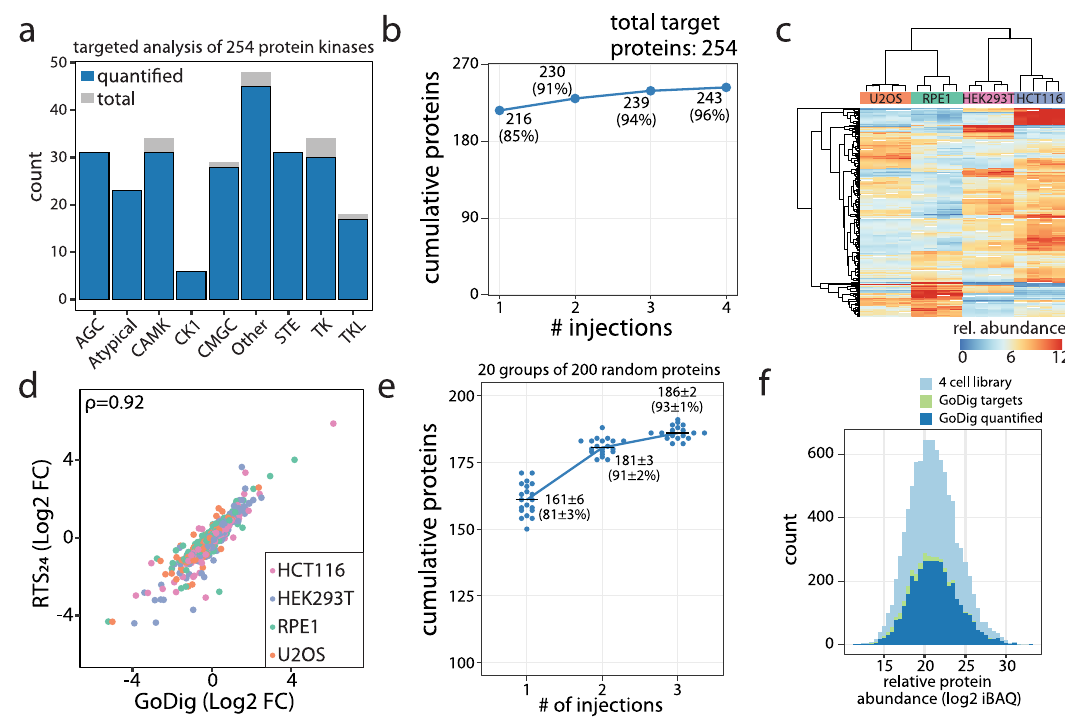
Fig. 3 | Evaluating the upper limit for proteome-wide targeting with lists of ~200 proteins. Low abundance proteins are much more dif fi cult to quantify, and they require ultra-long accumulation times. Using lists of 200 or more proteins is possible, but injection times are limiting across the full dynamic range of the proteome. a – d 254 protein kinases (479 peptides) were selected from the Lib 24 (~10,000 proteins) built with the TMTpro16-labeled four human cell sample as targets, and four consecutive GoDig runs were performed using ~1 µ g unfractio- nated sample while enabling the close-out feature. Close-out removes peptides/ proteins from the list once they have been quanti fi ed. In total, 216 kinases were quanti fi ed in a single GoDig experiment, and 96% of all targeted kinases were quanti fi ed using several injections with close-out. a Kinase subtypes targeted and quanti fi ed.SourcedataareprovidedintheSourceData fi le. b Proteinquanti fi cation events in the kinome assay including multiple GoDig injections with close-out.